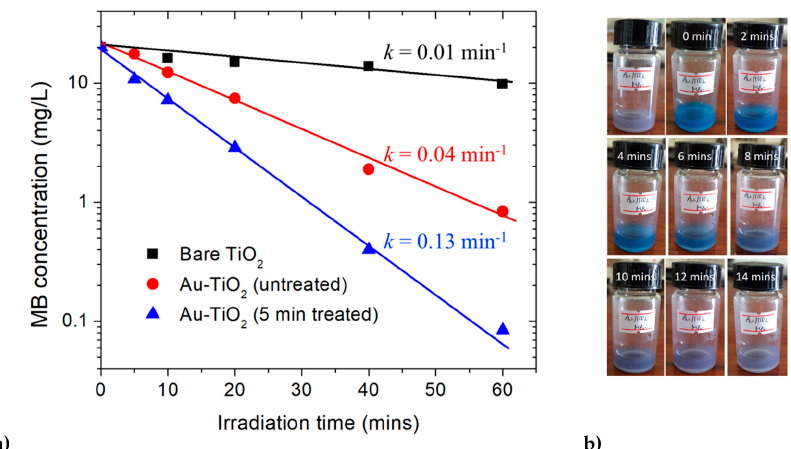
Figure 9. Kinetics of Methylene blue (MB) degradation (a) in the presence of bare TiO 2 and Au/TiO 2 nanocomposite in sunlight and decolorization of MB with Au/TiO 2 (5 min plasma treated) under sunlight radiation (b) .